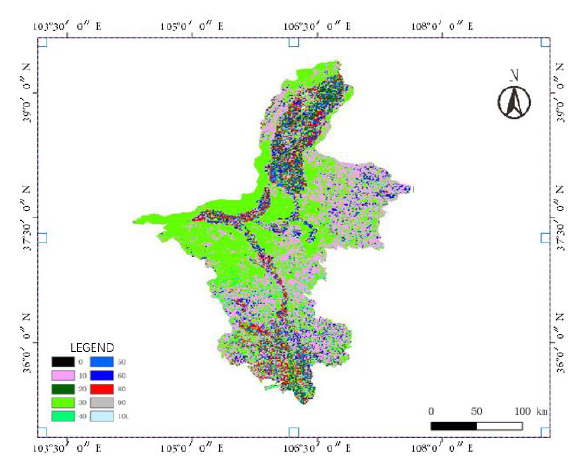
Figure 7 . k-means clustering results for semi-annual time series